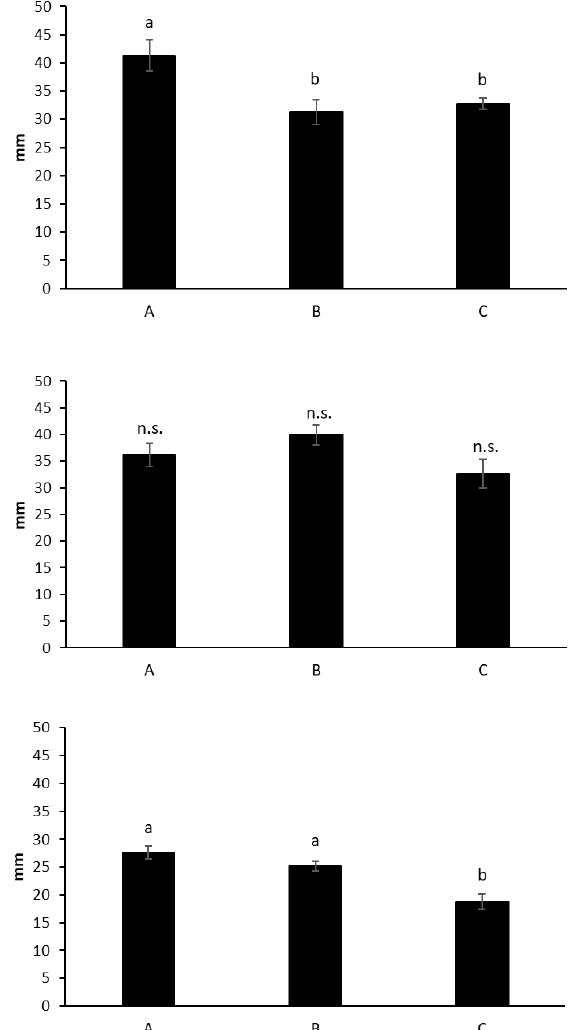
Figure 5. Annual ring thickness (mm) in the first three years of growth for plantations A, B, and C. Values are reported as mean ± s.e. Different letters at the tops of the bars indicate a significant difference among values measured for the plantations.